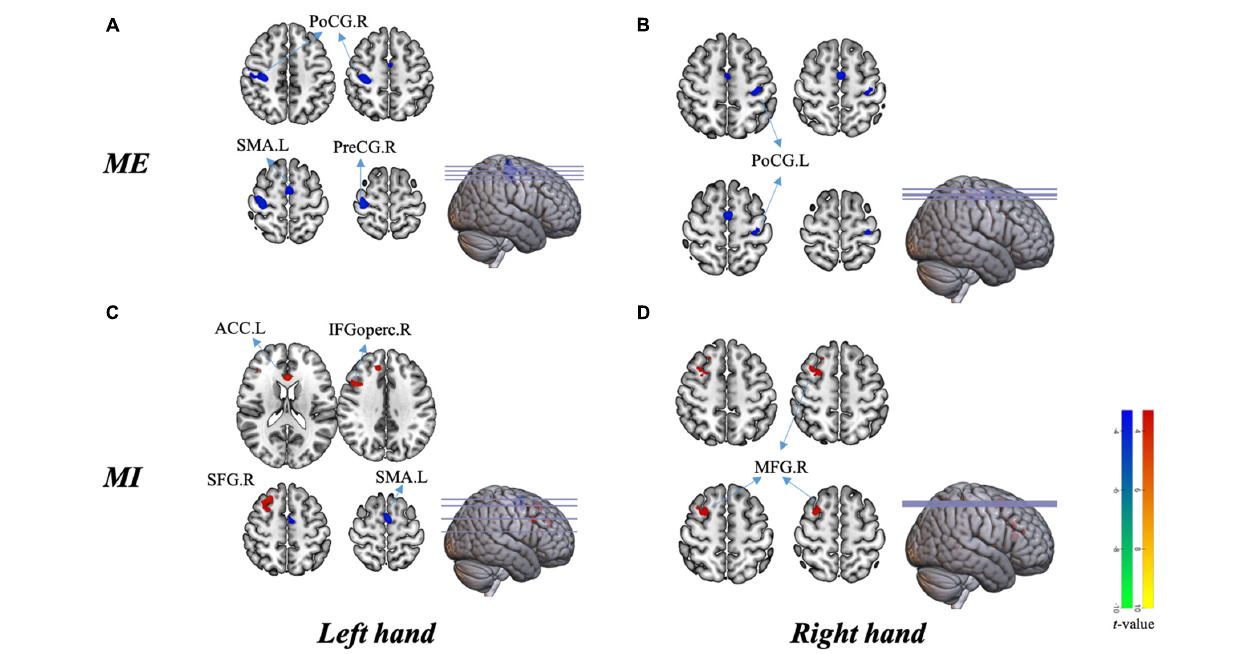
FIGURE 5 | Group differences in brain activation in the block design scan. (A) Activation in different areas during motor execution with the left hand [unaffected hand (UH)]. (B) Activation in different areas during motor execution with the right hand [affected hand (AH)]. (C) Activation in different areas during motor imagery with the left hand (UH). (D) Activation in different areas during motor imagery with the right hand (AH). PreCG.R, right precentral gyrus; PoCG.R, right postcentral gyrus; SMA.L, left supplementary motor area; PoCG.L, left postcentral gyrus; ACC.L, left anterior cingulate cortex; SFG.R, right superior frontal gyrus; IFGoperc.R, right opercular region of the inferior frontal gyrus; and MFG.R right middle frontal